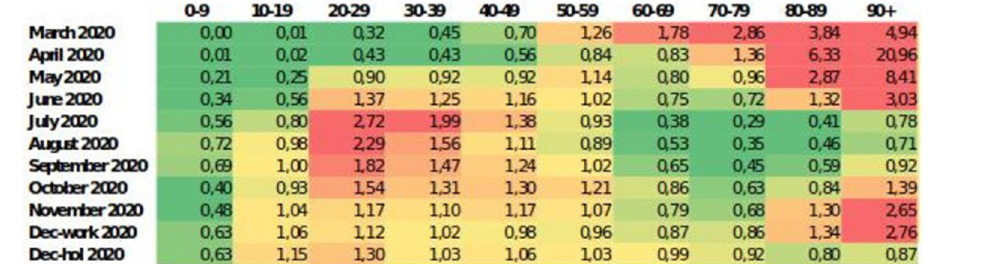
Fig 5. Heatmap of the ratio between homogenised monthly cumulative incidence by age group and that of Catalunya, excluding data from nursing homes. Colour scale indicates homogenised incidence below the mean (green) and above the mean (red), as shown by the legend. December has been split between working period (Dec- work) and Christmas holidays (Dec-hol).